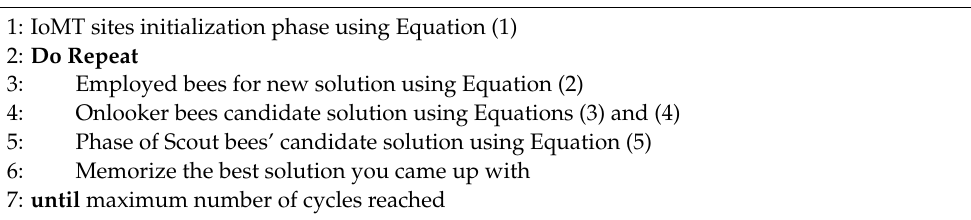
Algorithm 1: Working of Optimizer M-ABC